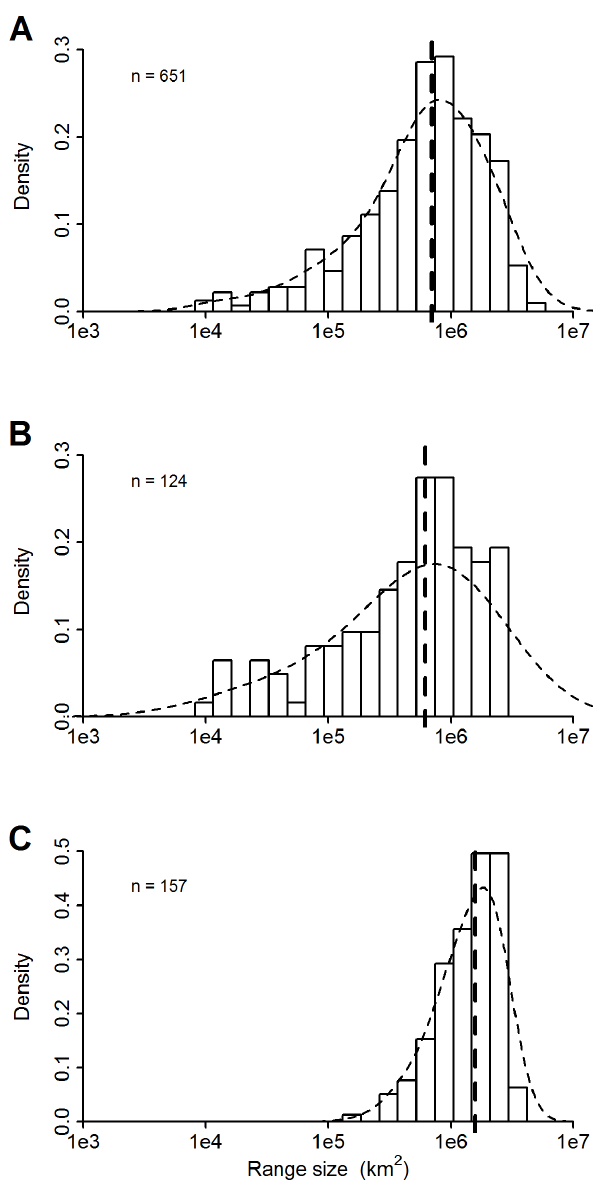
Figure 4. Histogram of species’ range sizes. Panel A is for all species in the study, panel B for all endemics, and Panel C for all species from the Gutianshan plot. In each case, only species with $ 20 geo- referenced records were included.